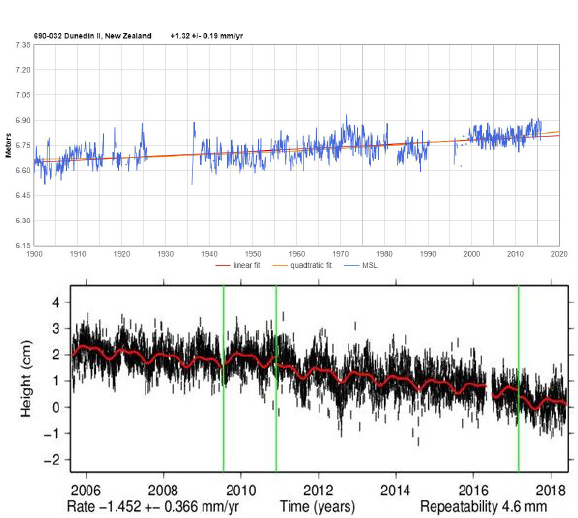
Figure 7: MSL (top) and GPS (bottom) data for Dunedin. Images reproduced and modified after http://www.sealevel.info/ and JPL